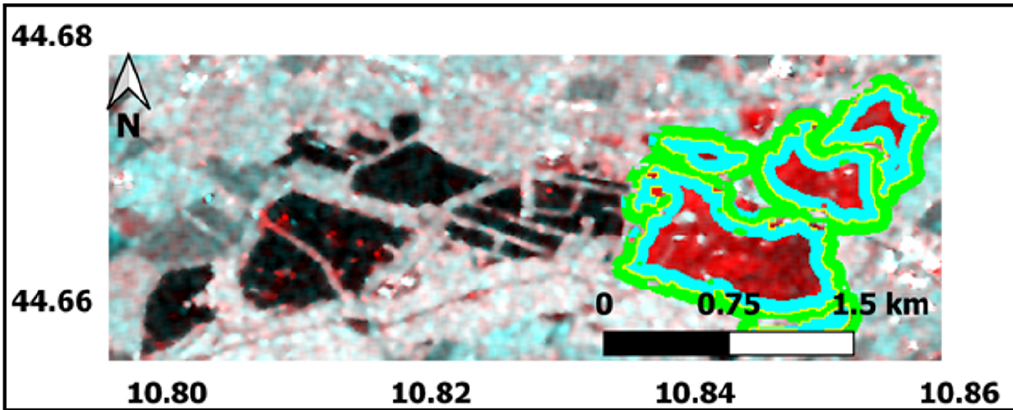
Figure 10. Same as Figure 8c, but with superimposed the land-floodwater edge (yellow), the buffer zone included in the MCDFA (cyan) and the buffer zone included neither in the MCDFA, nor in the CDFA (green).